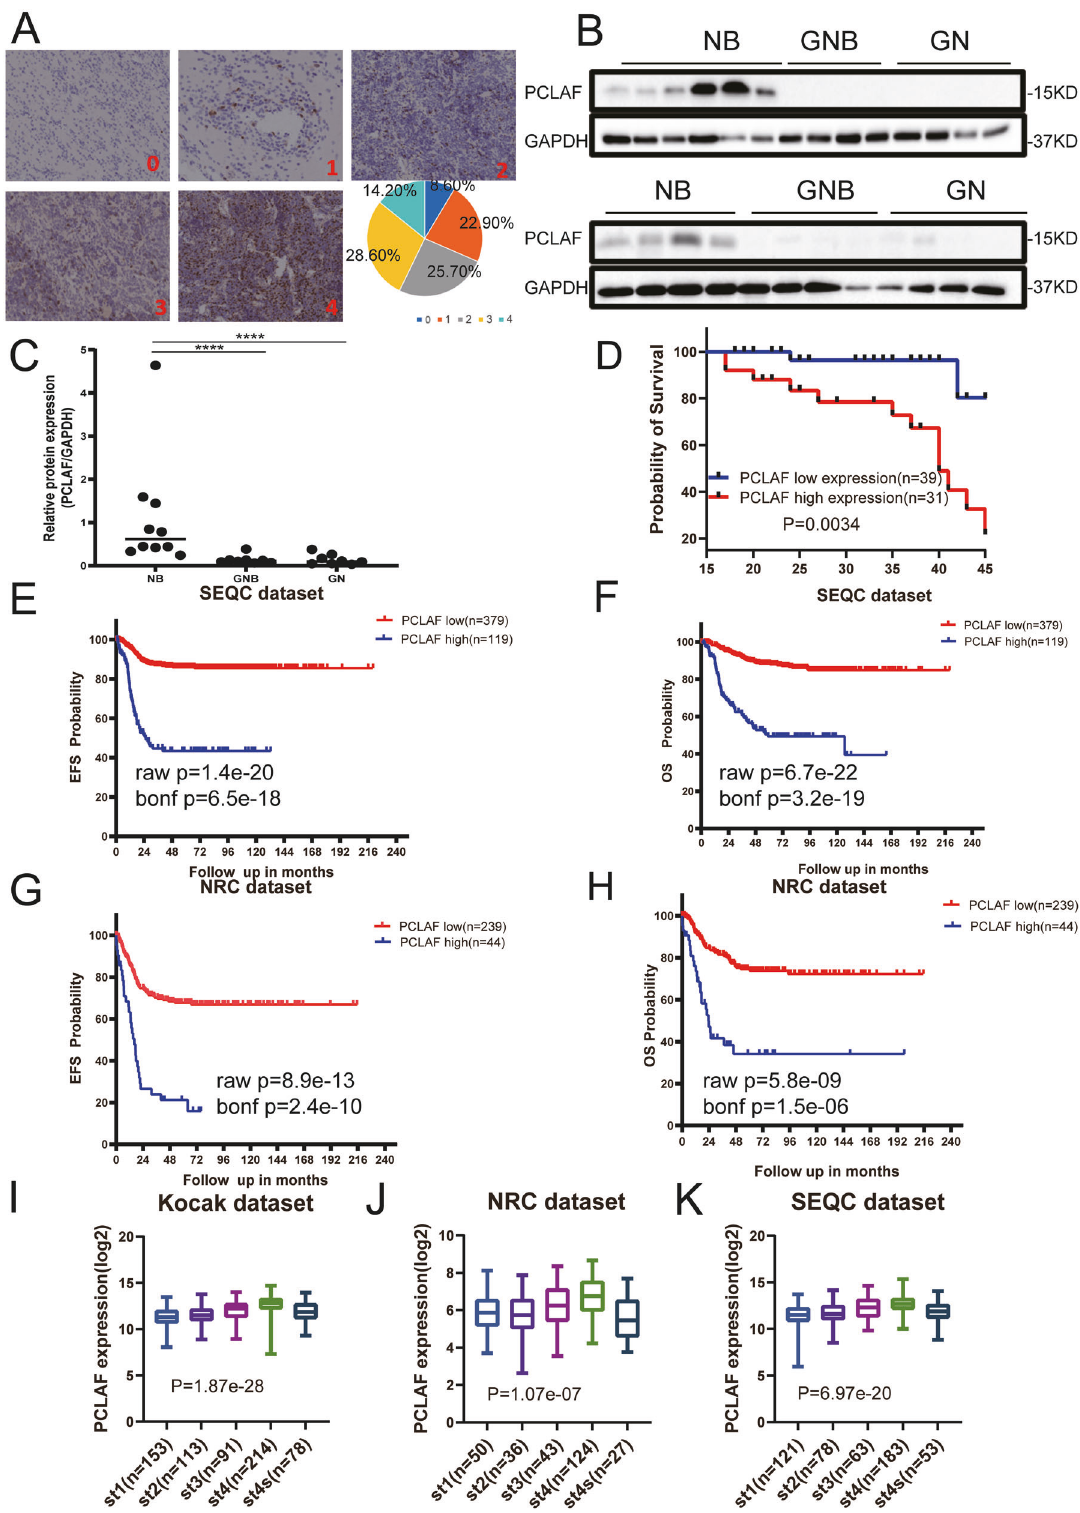
Fig. 1 Expression and roles of PCLAF in neuroblastoma. ( A ) Representative pictures of distinct levels (0 – 4) of IHC staining of PCLAF and the proportions of fi ve levels; ( B, C ) 10NB, 8GNB and 8GN tumor tissue proteins extracted for Western Blot to discover PCLAF expression, and Image J was used to quantify protein bands. The data in ( C ) were analyzed by Mann-Whitney U -test ( n = 28); ( D ) Kaplan-Meier analysis of OS in TMA of 70 neuroblastoma samples based on PCLAF expression with the log-rank test P value indicated; ( E – H ) Kaplan-Meier analysis of OS and EFS for the SEQC data set ( n = 498) and the NRC data set ( n = 275), based on PCLAF expression with the log-rank test p value indicated; ( I – K ) PCLAF expression levels in stage (St) 1-4 S tumors was show in box plot. ( *p < 0.05, *** p < 0.001and **** p < 0.0001, and bar graphs represent the mean ± SEM).